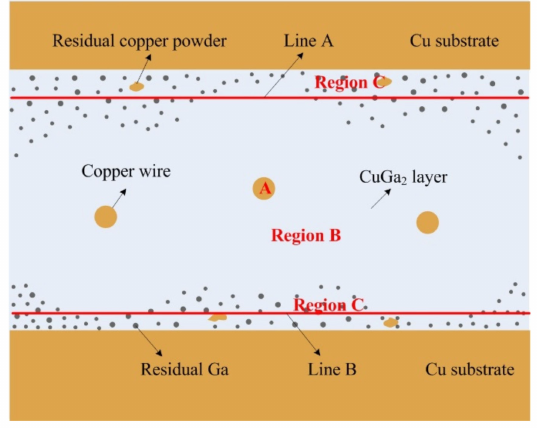
Figure 9. Diagram of fracture location in shear strength